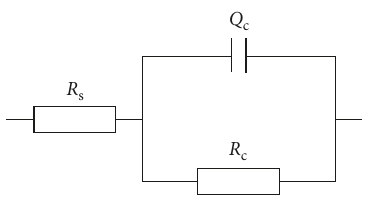
Figure 5: Circuit models for fitting the impedance of the